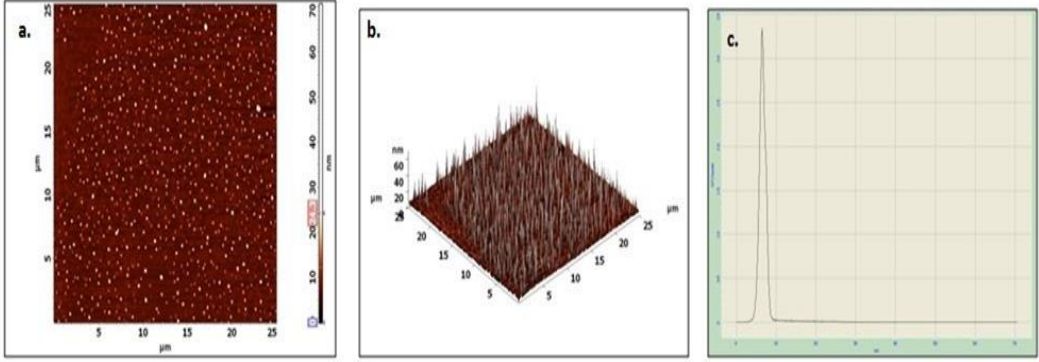
Figure 7. ( a – c ) AFM images of the PTAgNPs. Antibacterial activity of PTAgNPs.